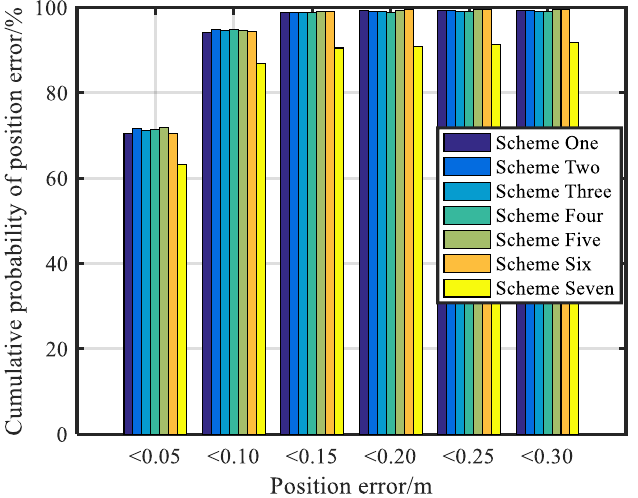
Figure 12. The cumulative probability of the position errors of the proposed schemes.